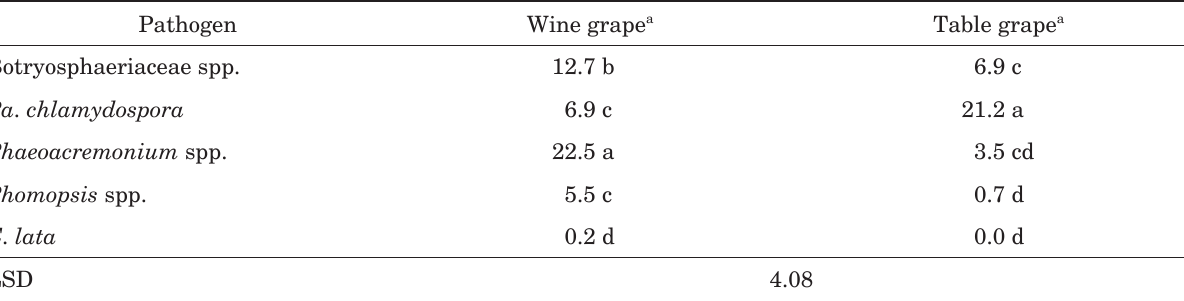
Table 3. Mean incidence of Phaeomoniella chlamydospora , Eutypa lata and species in the Botryosphaeriaceae, Pho- mopsis and Phaeoacremonium among isolates from wine and table grape vines in South Africa. Pathogen Table grape a Botryosphaeriaceae